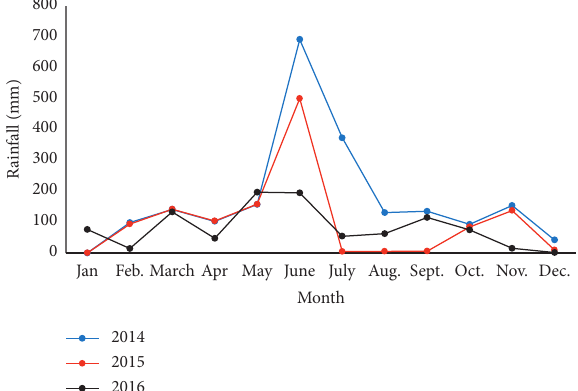
Figure 2: Rainfall data for 2014, 2015, and 2016 at the study sites. Source: Statistical Survey Department, Ellembelle District Assembly